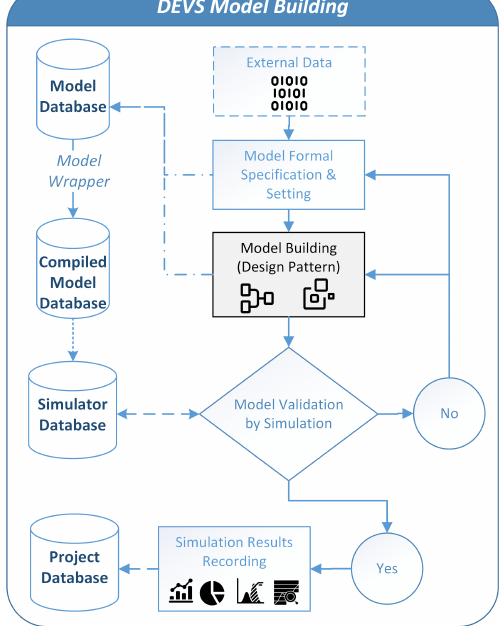
Figure 3. Process of building DEVS simulation models from external data (which may be massive) possibly used in the formal specification of DEVS models. Design patterns can be used in the block construction (black in the center of the figure) of the models. Validation of the models is carried out via simulation to obtain the traces necessary for analysis of the simulation results. The left part of the figure shows the management of models and simulation results in the associated databases.